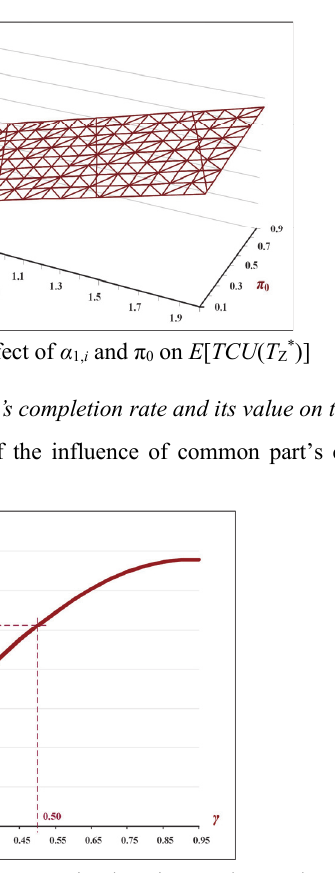
Fig. 13. The common part’s optimal uptime and rework time t 0 * concerning γ